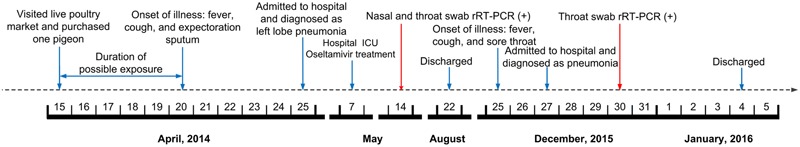
Timeline of events the patient associated with H7N9 and pH1N1 viruses infections in Wuxi, Jiangsu Province, China. rRT-PCR, real time reverse transcriptase-polymerase chain reaction; ICU, intensive care unit.